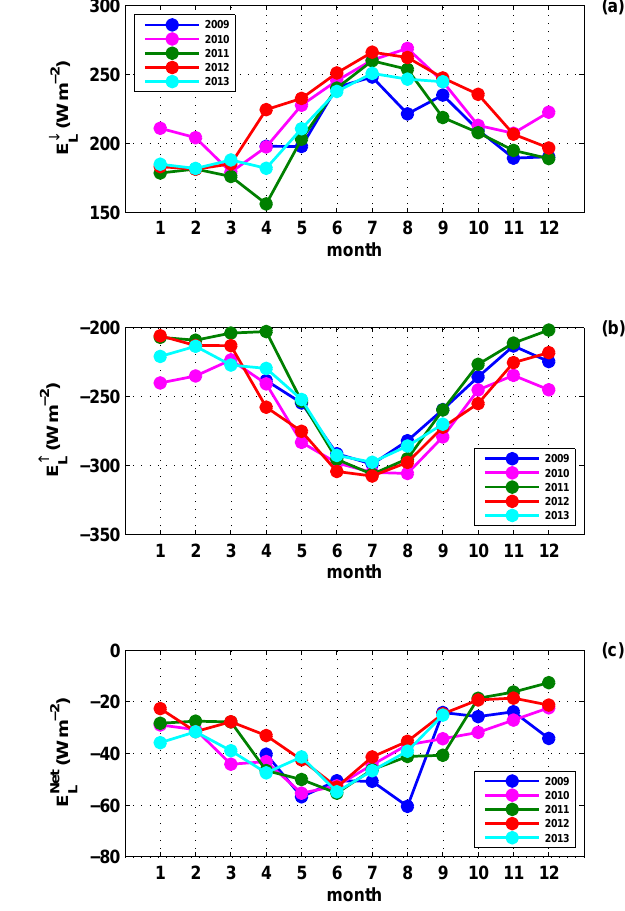
Figure 5. Seasonal cycles for the years 2009–2013 based on monthly averages of (a) incoming shortwave energy flux, (b) sur- face albedo, and (c) net shortwave energy flux.